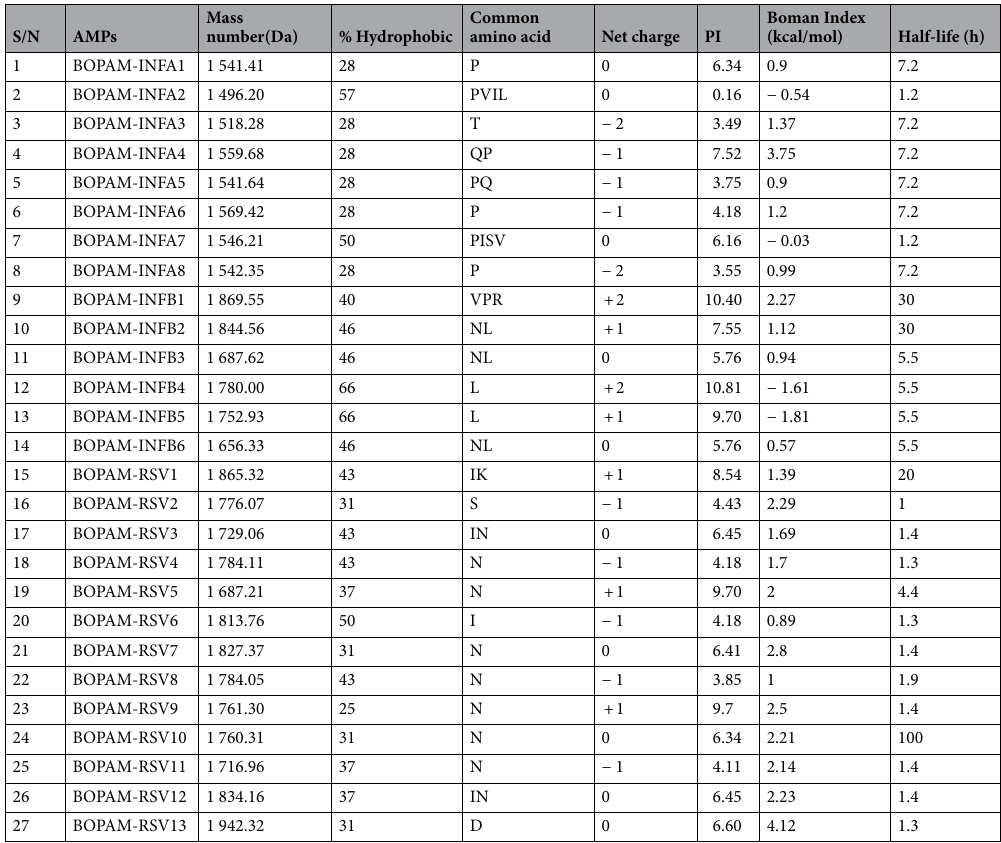
Table 5. Physicochemical parameter of the antibacterial and antiviral pneumonia putative AMPs. S/N serial number, BOPAM-INFA1-13 putative anti-Influenza A virus AMP, BOPAM-INFB1-7 putative anti-Influenza B virus AMP, BOPAM-RSV1-13 putative anti-Respiratory Syncytial Virus AMP, PI represents the isoelectric point of the